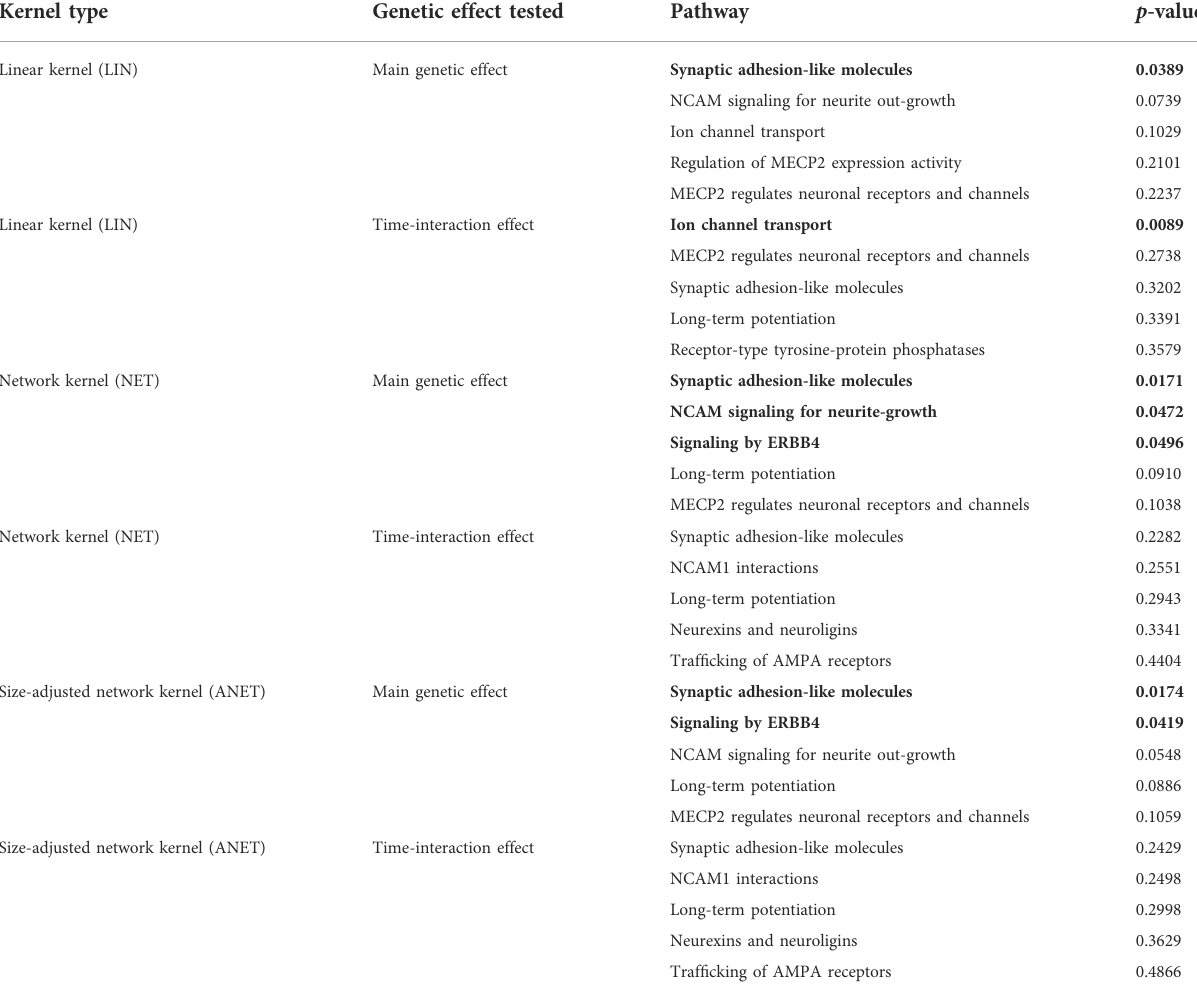
TABLE 6 Results of the real-data analyses without